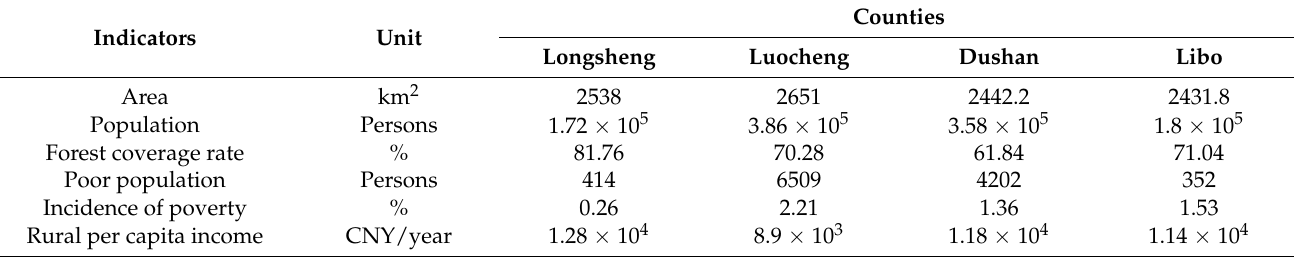
Table 1. The situation of four sample counties.